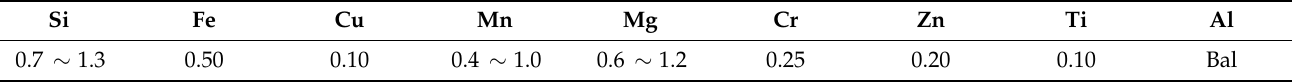
Table 1. 6082 Element Composition of Aluminum